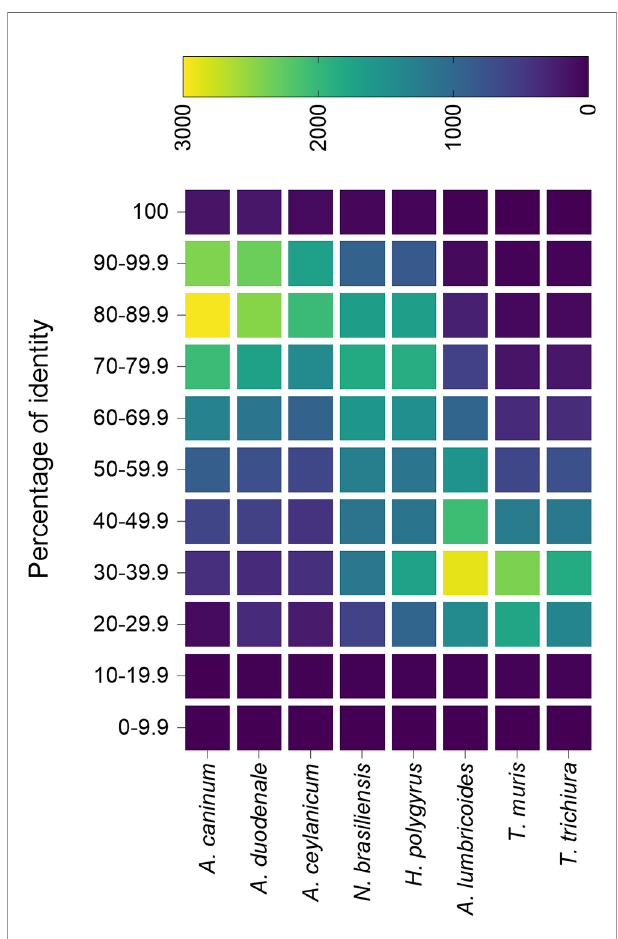
FIGURE 1 | Percentage identity of Necator americanus predicted proteome with the predicted proteins from different nematode species. The predicted proteome from different species of hookworm, hookworm mouse models and unrelated nematodes were compared against the predicted proteome from N. americanus and plotted in a heatmap. All predicted proteomes were downloaded from Parasite WormBase (v.14.0) and protein identity was calculated using Blast. Colour represents the number of proteins within a range of identity percentage.